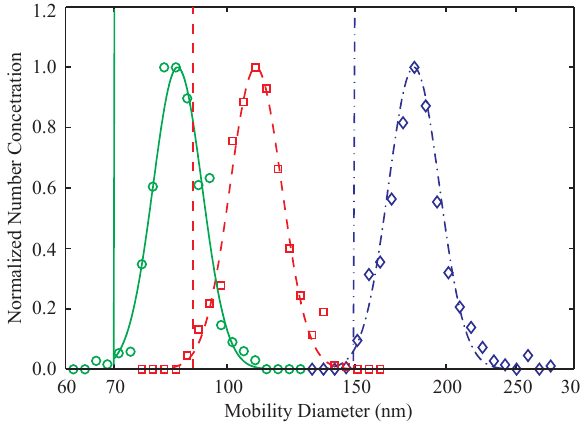
Fig. 3. Size distribution measurements of the humidified monodis- perse particle samples recorded by the HTDMA system. Particles having dry mobility diameters of 70 (green), 90 (red), and 150nm (blue) selected by DMA-1 at 30 ± 3% RH were exposed to 85% RH and measured by DMA-2 and the CPC. Symbols represent the actual measurements and lines the fitted curves determined by the TDMAFIT algorithm. One hygroscopic mode is observed in all the measurements, corresponding to growth factors of 1.22, 1.22 and 1.21, for the 70-, 90- and 150-nm dry particles, respectively.